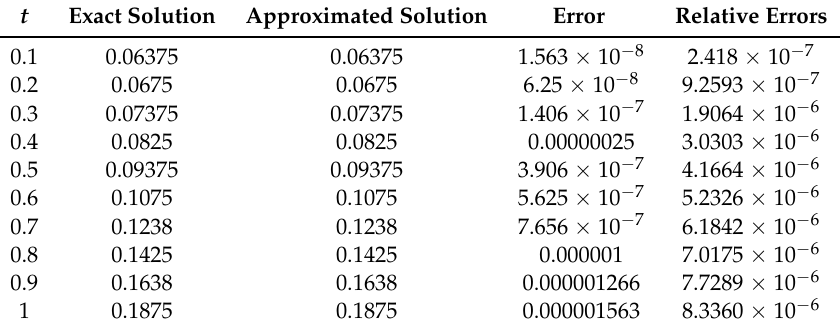
Table 3. Comparing Approximated and first component of exact solutions with